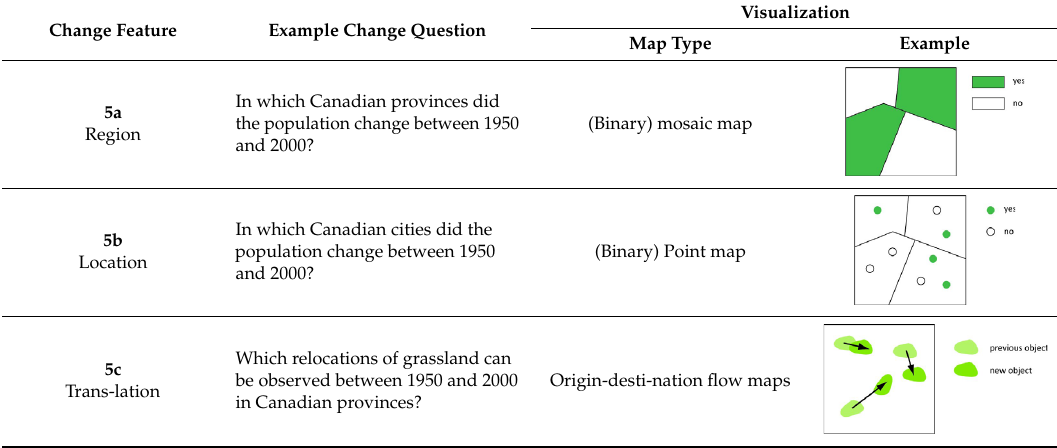
Table 5. Visualization of “Where” output clauses (compare classification in Table 2). Change